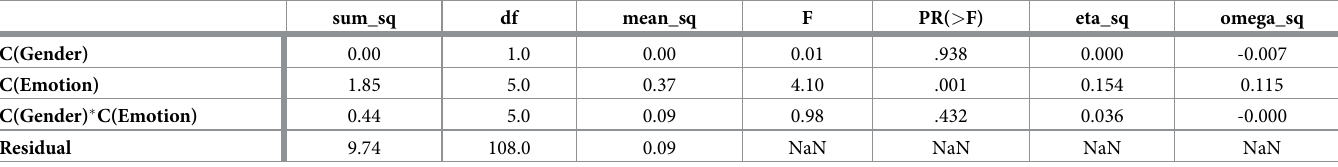
Table 17. Descriptive table for two-way ANOVA for Phase 2(for speaker gender).